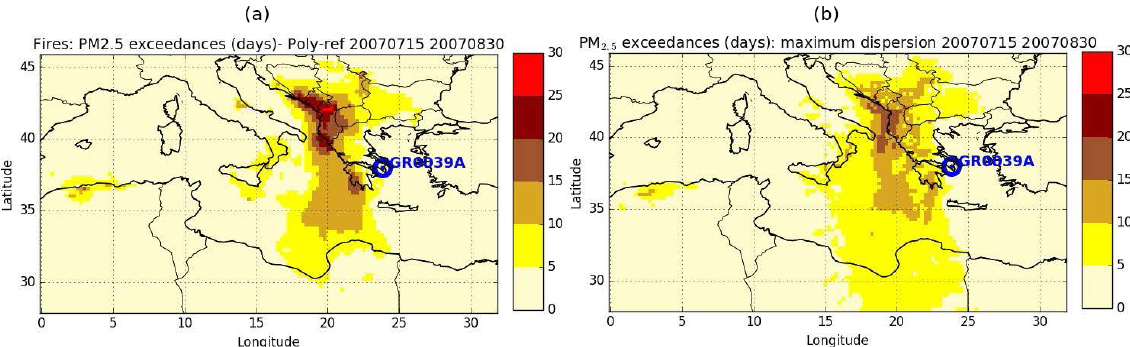
Figure 12. The additional days with PM 2 . 5 exceedances due to fires simulated by Polyphemus (difference between Poly-ref and Poly-Nofires ) (a) and the maximum statistical dispersion ( σ ) related to fire emissions for additional days of PM 2 . 5 exceedances due to fires (b) during the summer of 2007 (from 15 July to 30 August